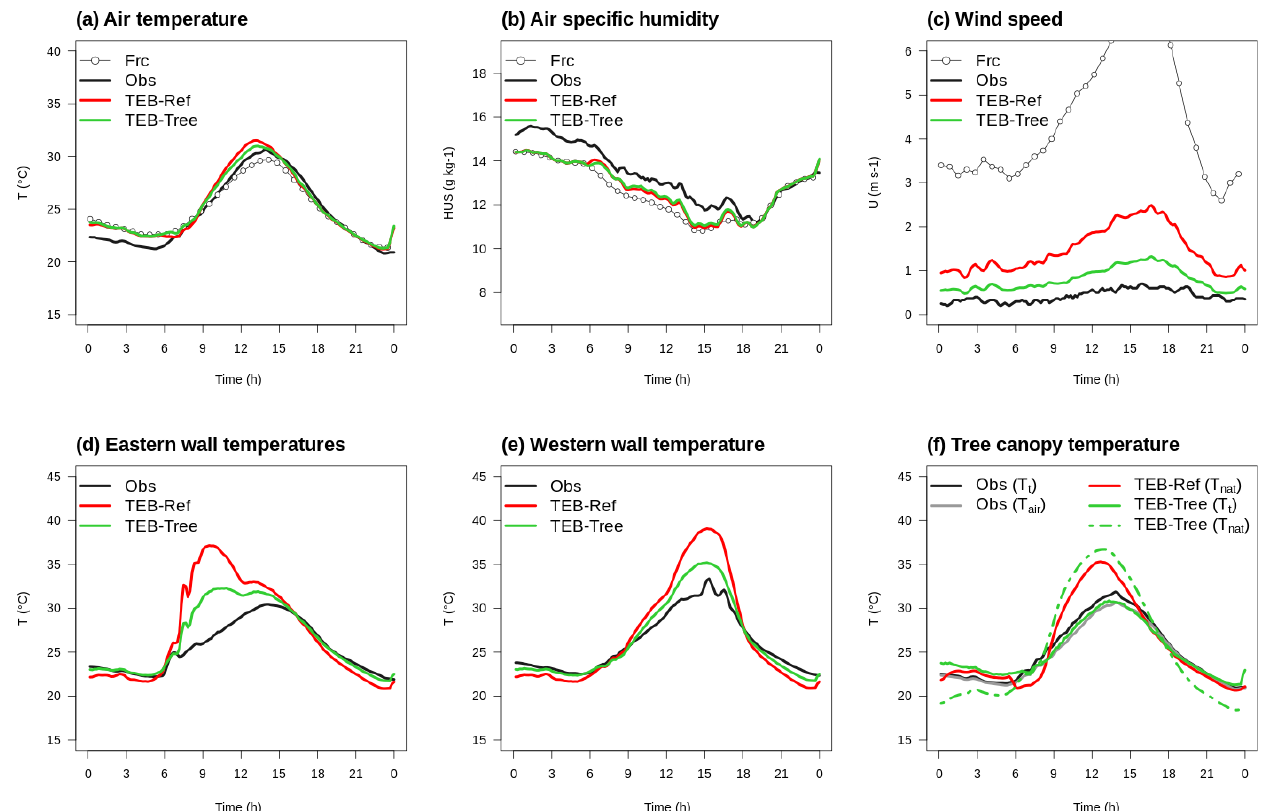
Figure 3. Comparison of the TEB-Ref and TEB-Tree results (red and green lines, respectively) with meteorological variables (a–c) and surface temperatures of urban facets and trees (d–f) measured within the courtyard (black line). For air temperature, specific humidity and wind speed, the gray line with symbols indicates the forcing data above the